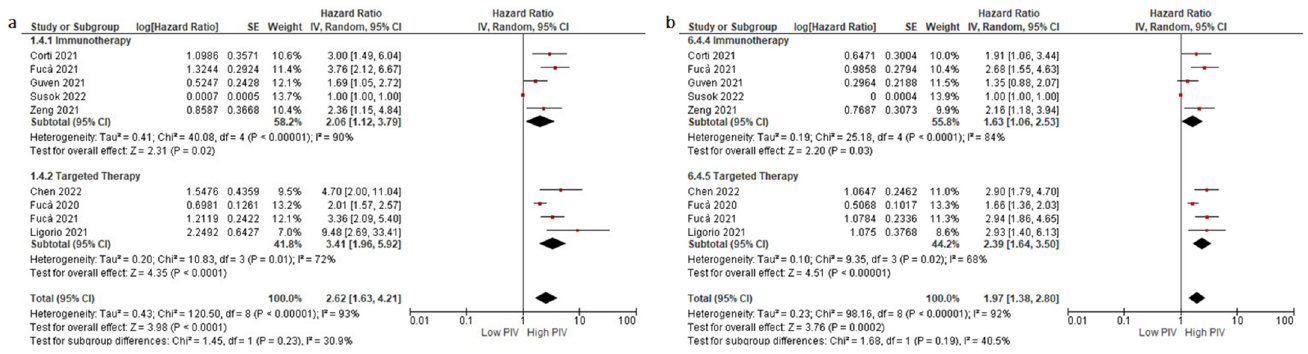
Figure 2. Subgroup analyses according to disease stage in OS ( a ) and DFS/PFS ( b ). Lines ( ○ ) indicate 95% CIs. Diamond ( ♦ ) indicates the pooled effect size.